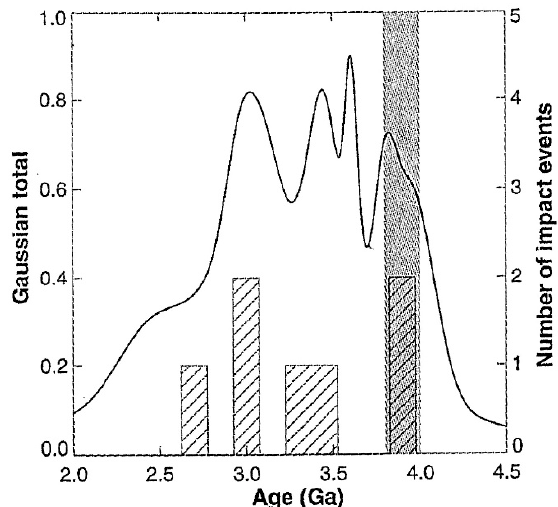
Figure 7. Age distribution data from 31 lunar meteorite impact melt clasts discussed by Cohen et al. (2000 [69]), and proposed in their title “support for the lunar cataclysm hypothesis.” Cross-hatched data are histogram of best estimates for dates of seven large “impact events.” Shaded area is a 200 Ma interval “representing lunar cataclysm.” The curve is an ideogram adding Gaussian curves representing uncertainty of dates for the 31 samples. Following “Ryder’s rule,” the support for terminal cataclysm was proposed because none of the impact melt clasts pre-dated the proposed cataclysm. Note that time flows from right to left, contrary to most of our diagrams.